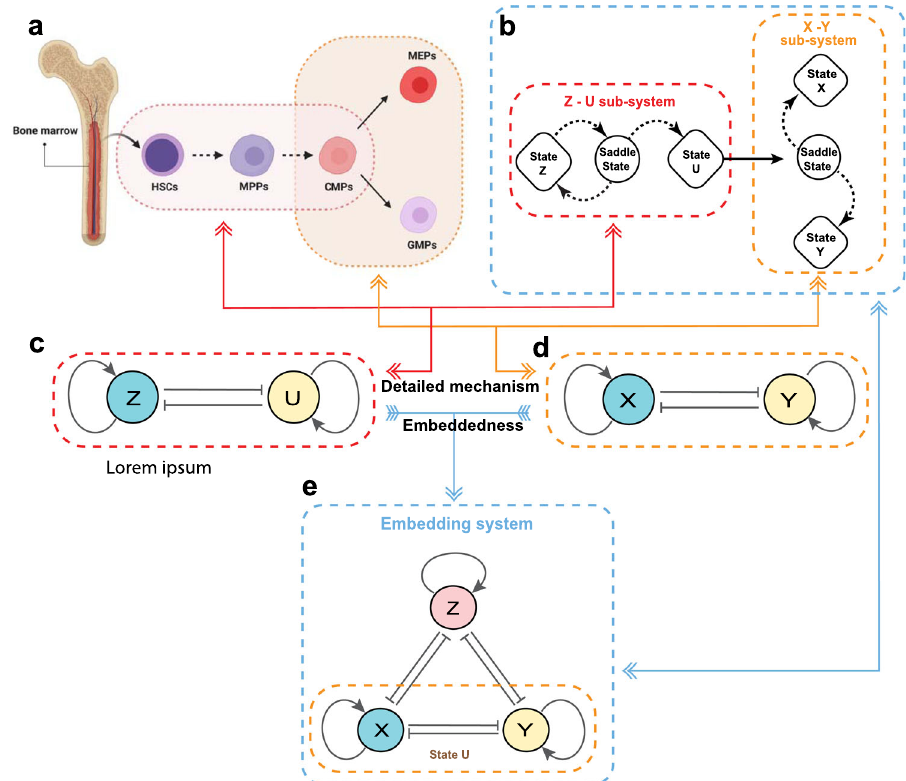
Fig. 1 Methodology for developing multistable models by embedding two sub-systems with bistability together. a Brief fl owchart of hematopoietic hierarchy that is created with BioRender.com. HSCs hematopoietic stem cells, MPPs multipotent progenitors, MEPs megakaryocyte-erythroid progenitors, GMPs granulocyte-macrophage progenitors. b The principle of embeddedness: Z - U module is the fi rst bistable sub-system. Once this module crosses the saddle point from state Z to state U , it enters the X - Y sub-system that has two stable steady states X and Y , reaching either state X or state Y via the auxiliary state U . c , d The structure of two double-negative feedback loops with positive autoregulations, which is the mechanisms for bistable sub-systems in HSCs. e The structure and mathematical model of regulatory network after embeddedness. The X - Y sub-system is embedded into the state U